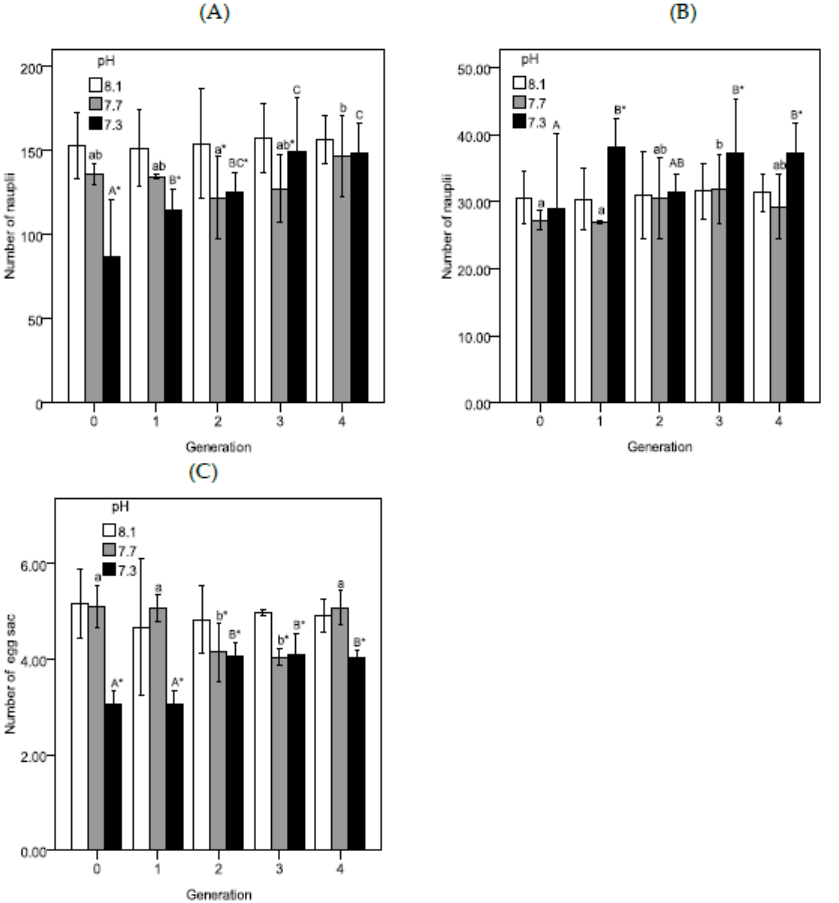
Figure 3. Effect of seawater acidification on the fecundity (mean ± standard deviation, n = 6) of T. japonicus in five generations. All of the generations were exposed to the same pH. ( A ) The